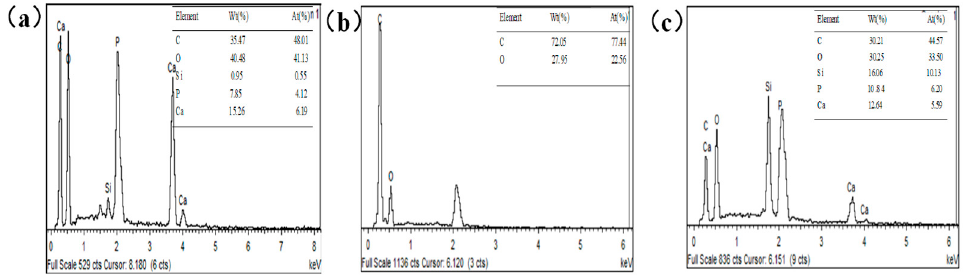
Figure 5. EDS images of ( a ) nano-HAp, ( b ) pristine PU sponge, and ( c ) nano-HAp/PU sponge.